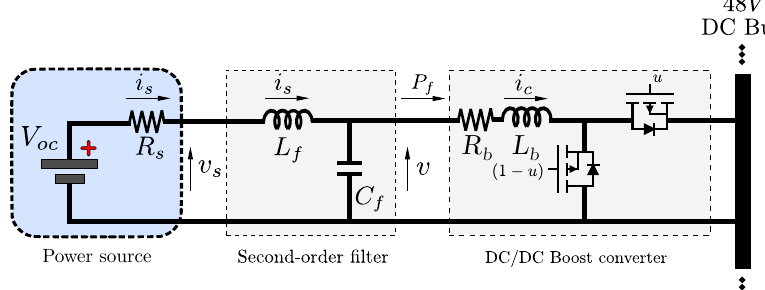
Figure 10. Electrical diagram of the PCS based on boost converter with second-order input filter.